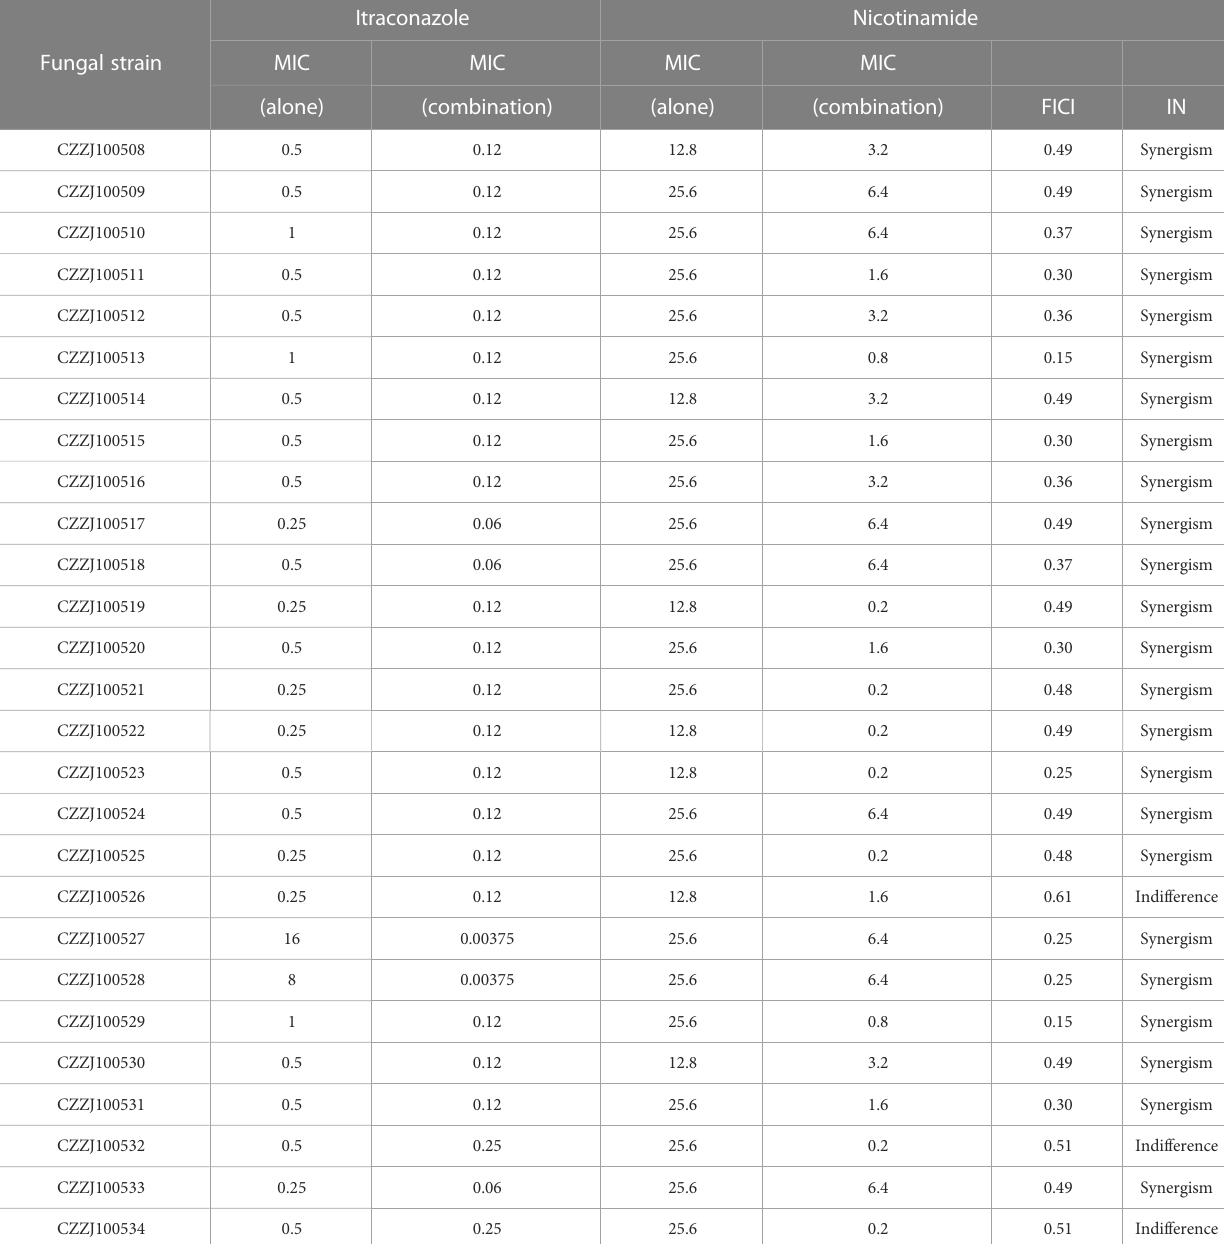
TABLE 2 Results of inhibition interactions between itraconazole and nicotinamide against Aspergillus fumigatus in the checkerboard assay.